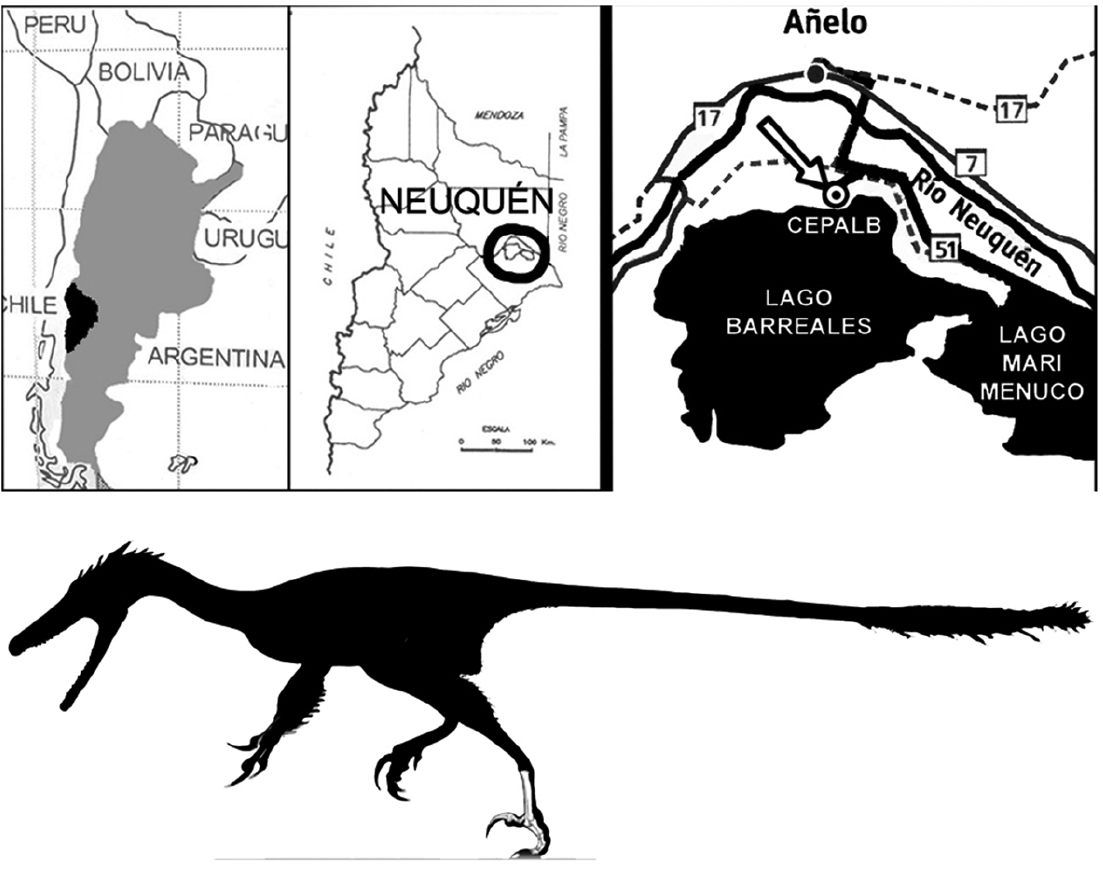
Fig. 1 – Map showing the locality of Pamparaptor .